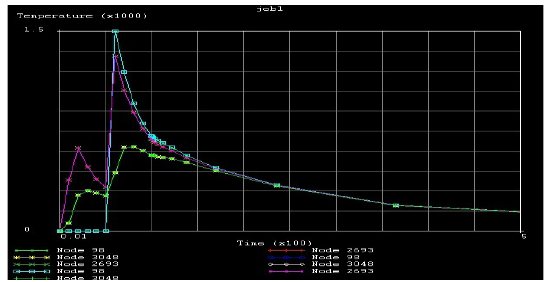
Figure 8 Thermal cycling curve of three nodes It can be seen from Fig. 8 that the thermal cycling